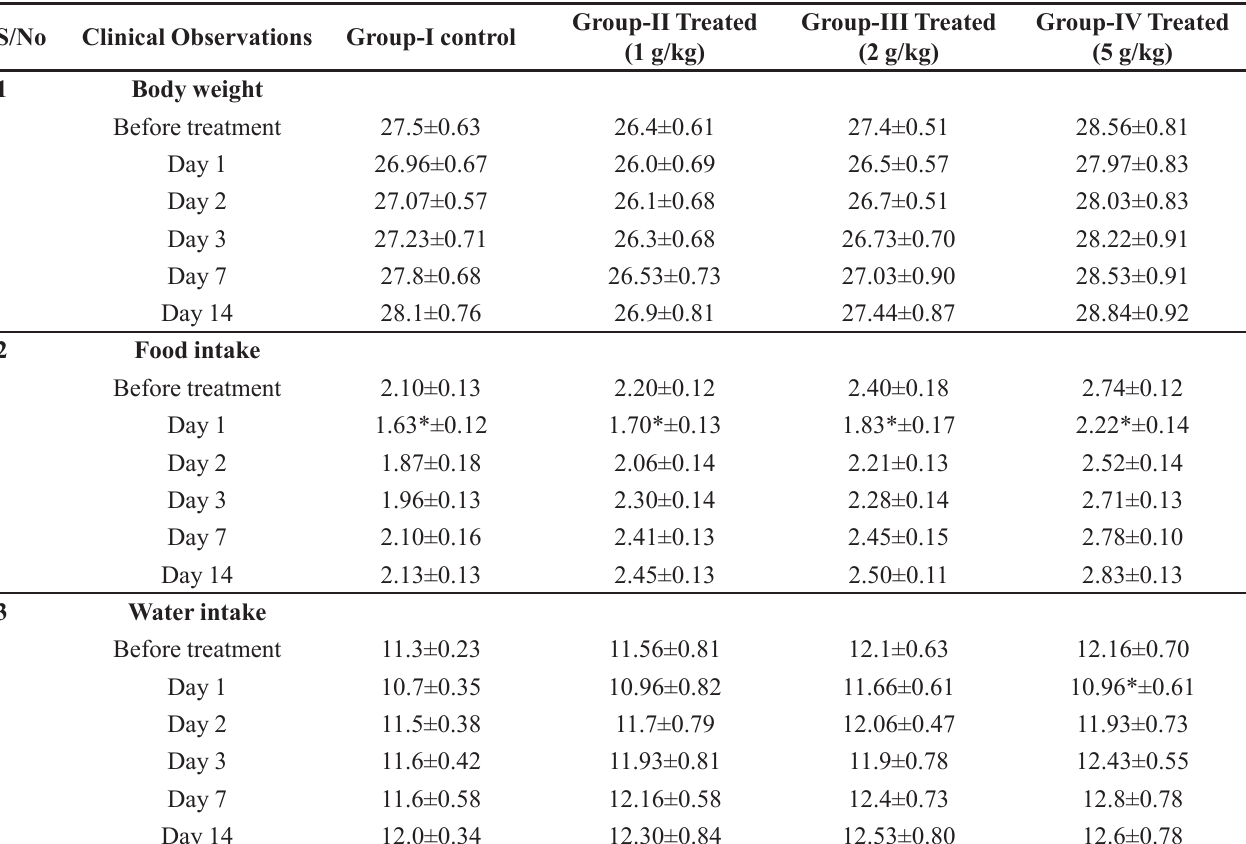
TABLE I - Results of body weight, and food and water consumption by control and treated groups of albino mice